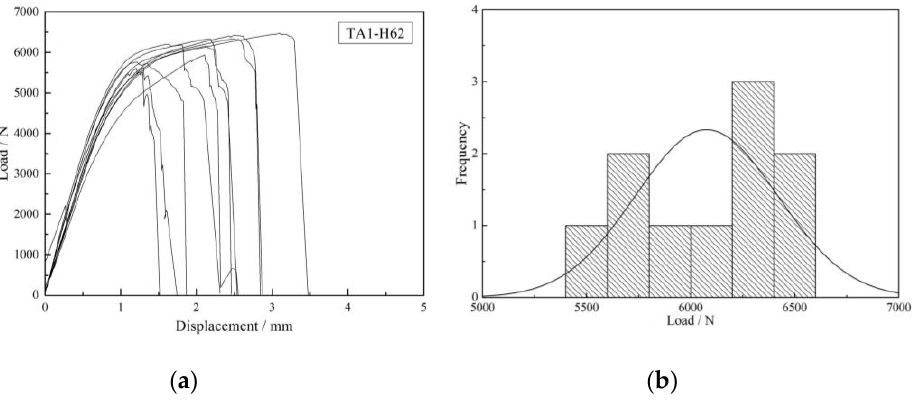
Figure 5. Force-displacement curves and histogram of maximum shear strength of the STH joints. ( a ) Force-displacement curves; ( b ) Histogram of maximum shear strength.